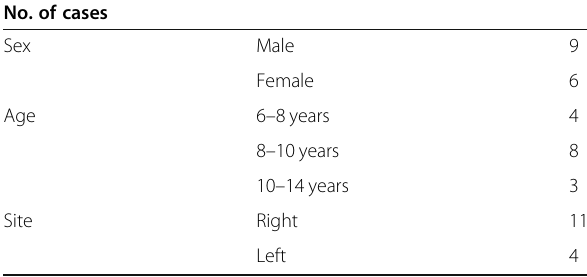
Table 1 Demographic data of the